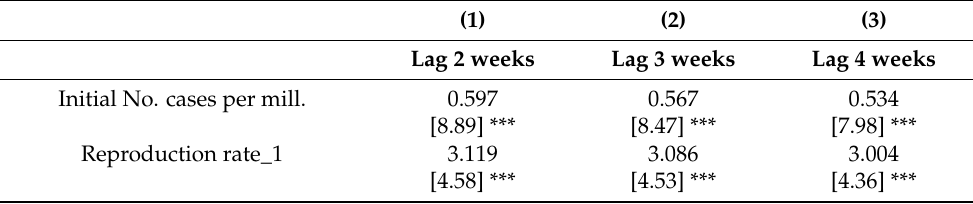
Table A3. Impact of vaccination rate on number of new COVID cases, sample of EU countries. (1) (2) (3) Lag 2 weeks Lag 3 weeks Lag 4 weeks Initial No. cases per